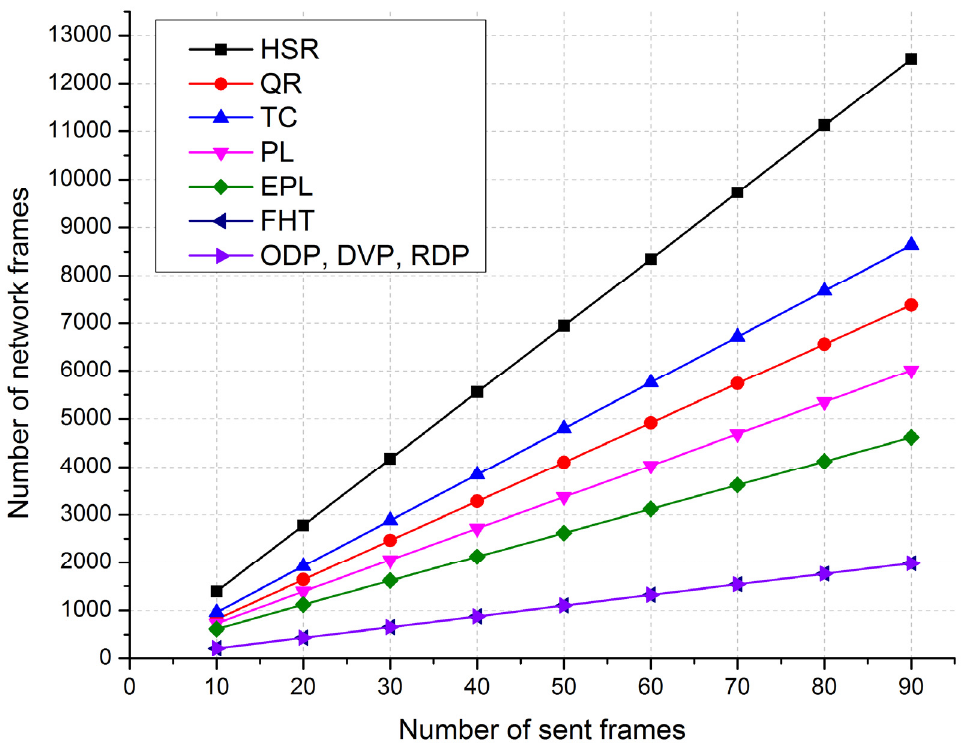
Figure 13. A comparison of the traffic performance of traffic reduction